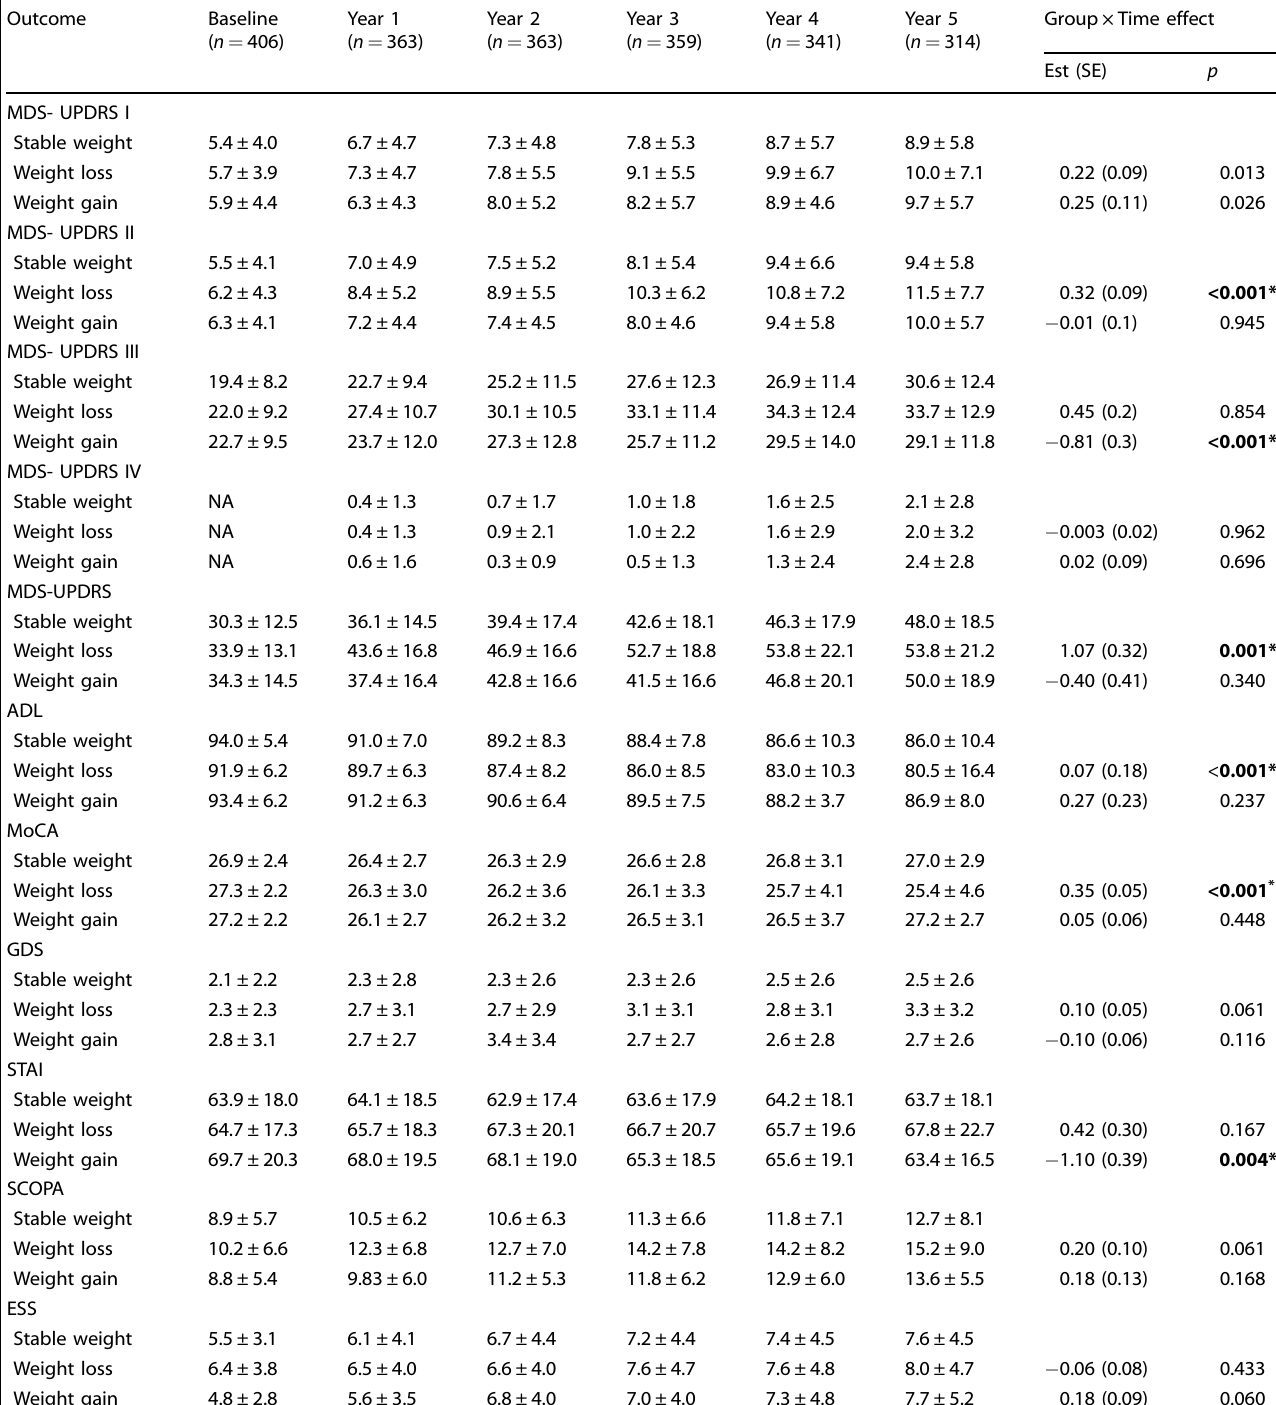
Table 3. Generalized linear mixed analysis for the comparison of the progression over time of clinical variables between de novo Parkinson ’ s patients with stable weight, weight loss, or weight